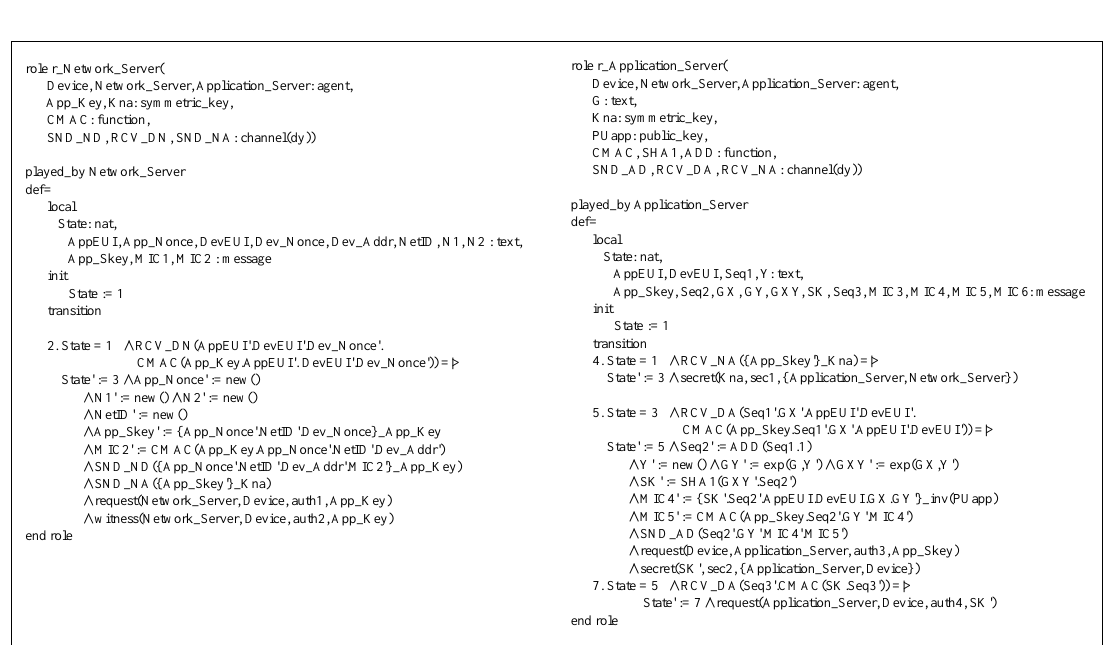
Figure 8. r_Device role.